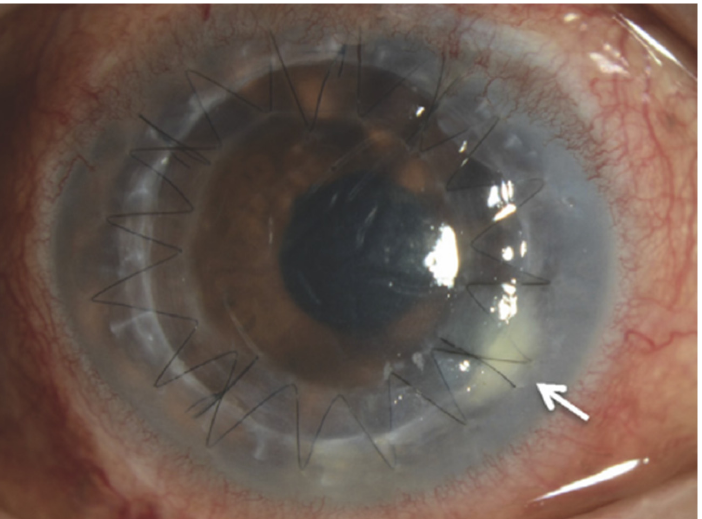
Figure 2. Slit-lamp examination showing that small white infiltrates were observed at the